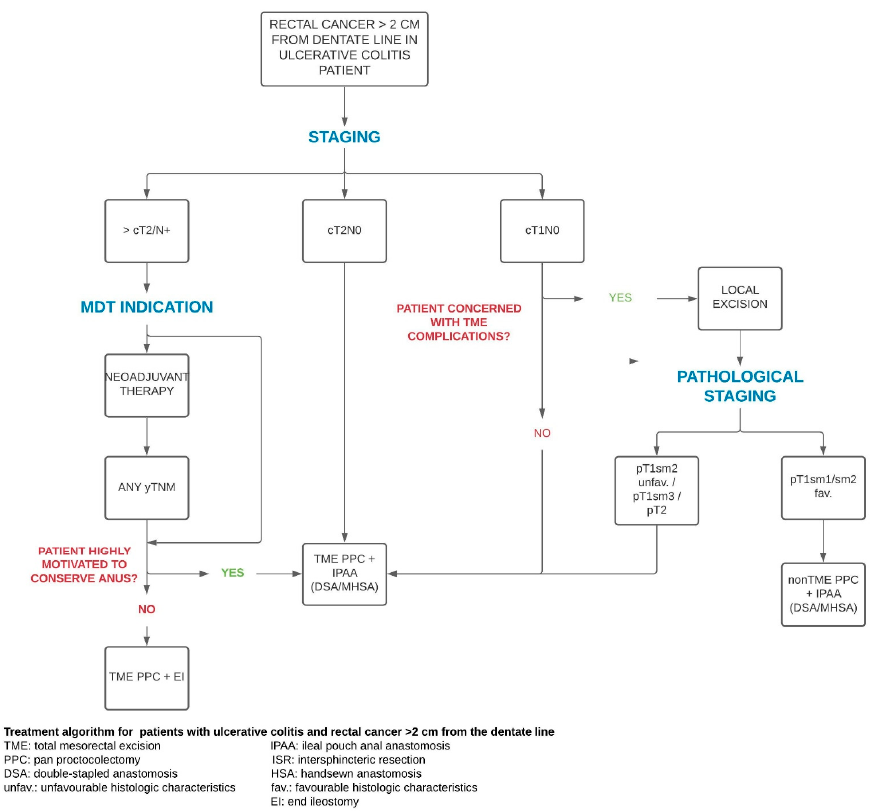
Figure 5. Treatment algorithm for patients with ulcerative colitis and rectal cancer >2 cm from the pectinate line.